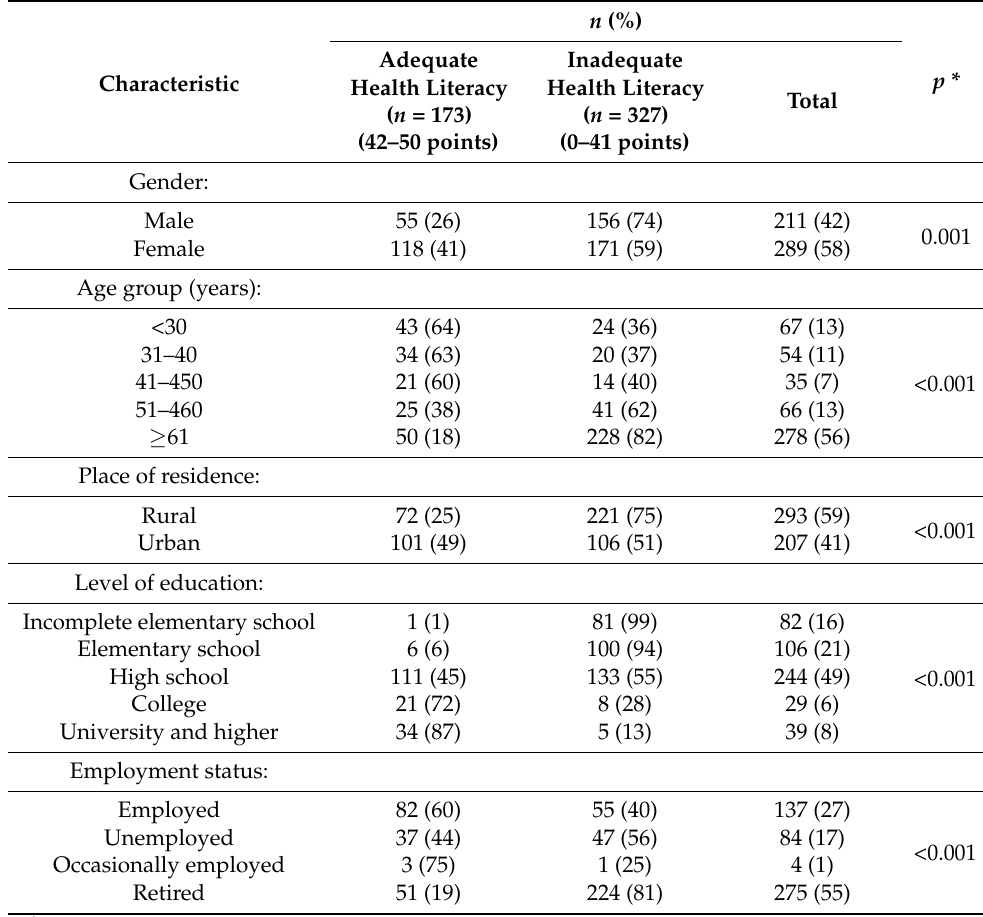
Table 4. SAHLCA-50 score according to demographic characteristics ( n =